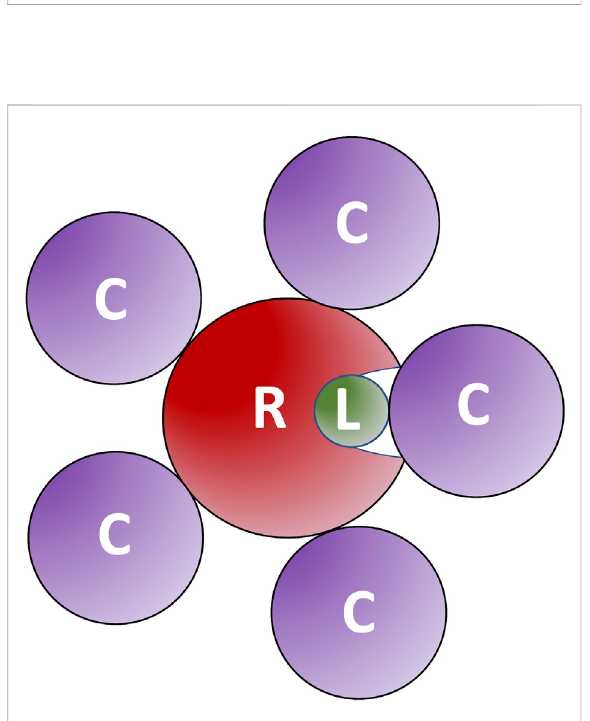
FIGURE 7 Large crowders block ligands less effectively than